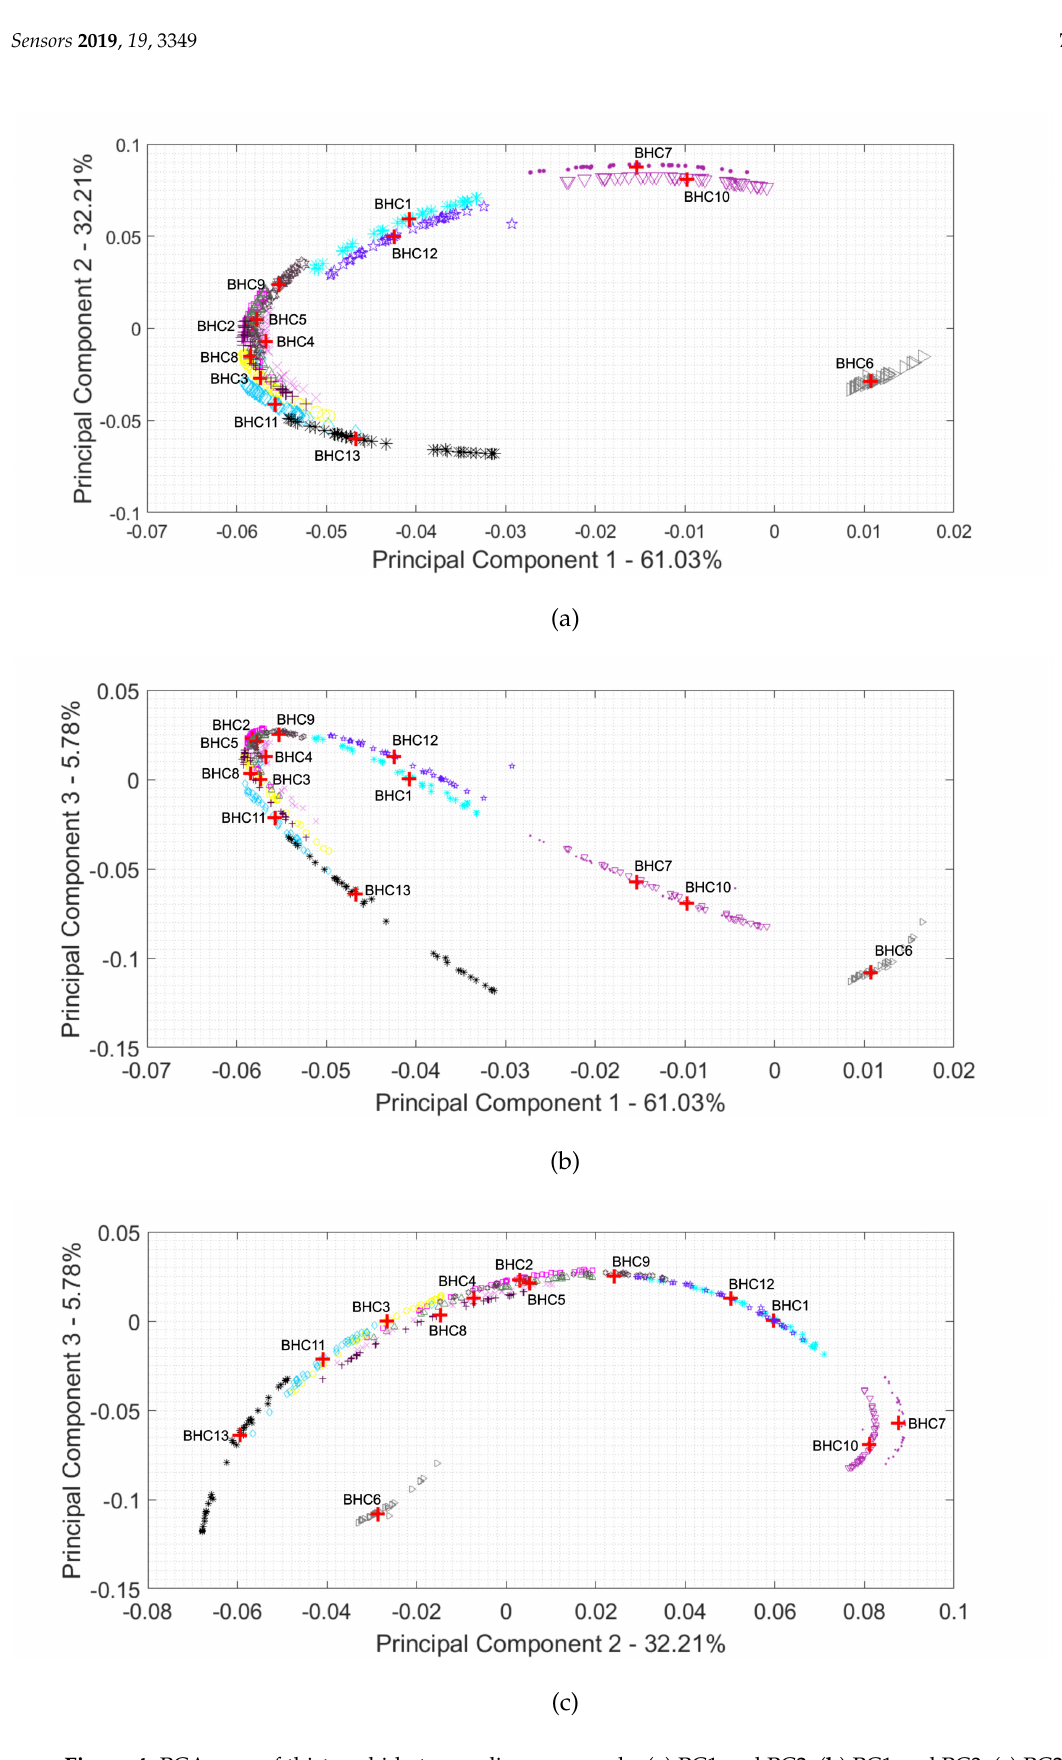
Figure 4. PCA map of thirteen bi-heterocyclic compounds: ( a ) PC1 and PC2; ( b ) PC1 and PC3; ( c ) PC2 and